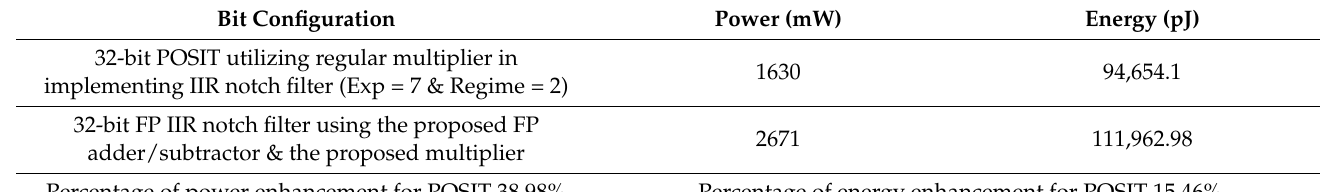
Table 10. Comparison of the power and energy between a 32-bit POSIT IIR notch filter utilizing a regular multiplier and a 32-bit floating point second-order IIR notch filter.